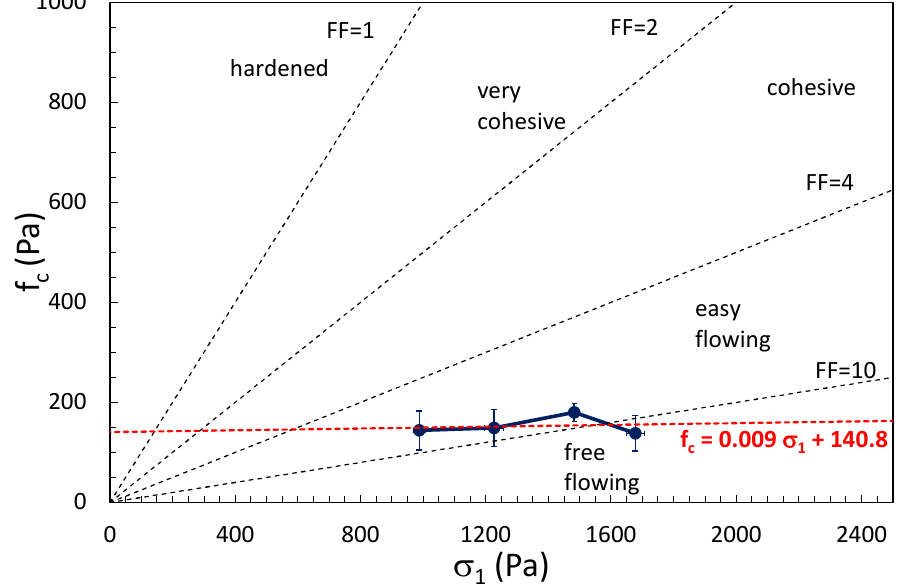
Figure 11. Flow function for polyamide 6 and the corresponding regression line (red hyphenated line). FF (black hyphenated lines) is the flow factor.